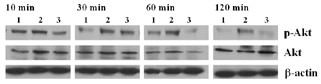
Activation of phosphorylated Akt after interleukin (IL)-17 induction by anti-CD3 antibody, and its inhibition by LY294002. Peripheral blood mononuclear cells were cultured with medium only (lane 1), anti-CD3 antibody (10 μg/ml; lane 2) or anti-CD3 antibody (10 μg/ml) plus LY294002 (20 μM; lane 3) for 10–120 min. Cell lysates were analyzed for Akt activation by western blot analysis of total and Ser473-phosphorylated Akt (P-Akt) using specific antibodies. Levels of phosphorylated Akt were compared at each time point, after normalization to Akt and β-actin in the same sample. A representative example of three separate experiments is shown.